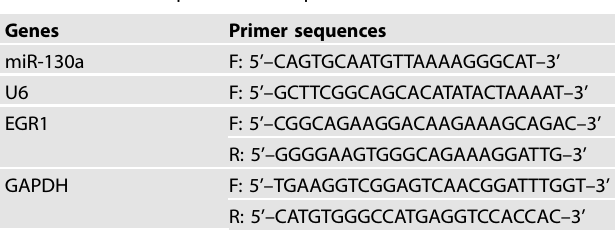
Fig. 6 The mechanistic diagram. Dex upregulates miR-130a to suppress EGR1 expression, thereby inhibiting the proliferation, invasion and migration of and promoting apoptosis of HCC cells. Table 3. Primer sequence for